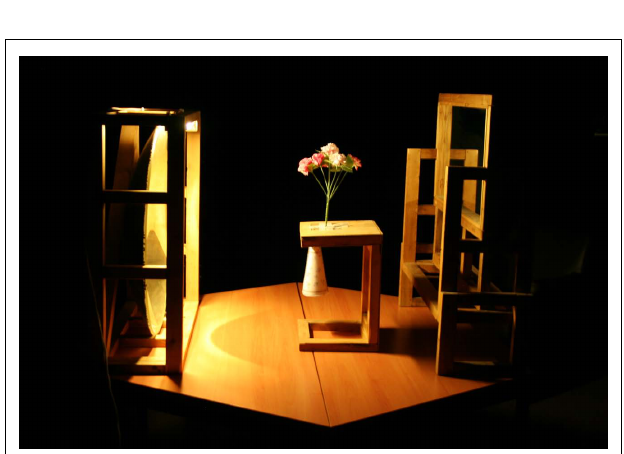
FIGURE 3 | Reconstruction of Lacan’s double-mirror set-up.